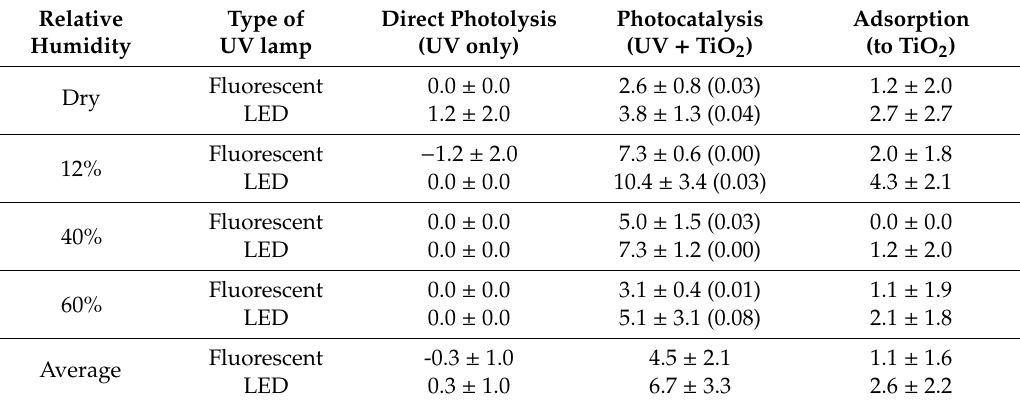
Table A1. NH 3 mitigation under di ff erent light types and relative humidity at a treatment time of 40 s. Value in the table report % reduction ± standard deviation ( p -value). Bold font signifies statistical